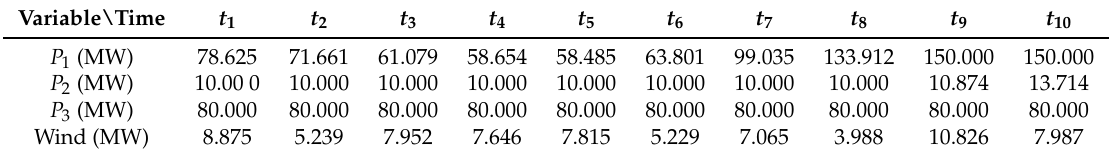
Table 7. Economic dispatch with Monte Carlo